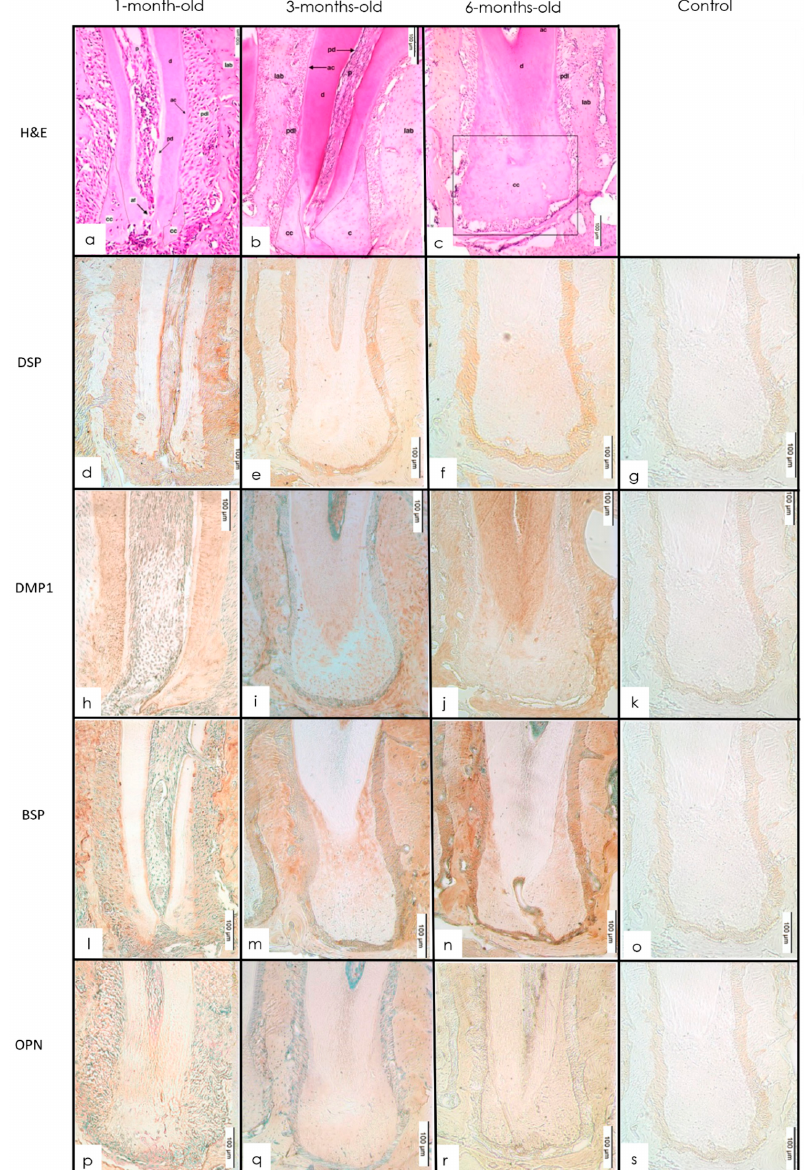
Figure 5. ( a – c ) H&E molar showing cementum at 1-, 3-, and 6-month-old mice (H&E 20 × ). The cementum and apical bone are well-developed in all age groups and the root apex continues develop- ing with abundant cellular cementum. d—dentin; pd—predentin; o—odontoblastic layer; p—pulp; fb—furcal bone; pdl—periodontal ligament; tf—transeptal fibers; Iab—interproximal alveolar bone; cc—cellular cementum; ac—acellular cementum; af—apical foramen. ( d – g ) Expression of staining intensity of DSP at 1, 3, and 6 months in cellular cementum and PDL of the tooth root. With anti- DSP (IHC 20 × ). Intensity decreased from 1 to 3 months followed by a slight increase at 6 months. ( h – k ) IHC staining of cellular cementum and PDL in tooth root in 1-, 3-, and 6-month-old mice with anti-DMP1 (IHC 20 × ). The intensity increased from 1 to 3 months followed by an increase between 3 and 6 months. ( l – o ) IHC staining of cellular cementum and PDL in tooth root in 1-, 3-, and 6-month-old mice with anti-BSP (IHC 20 × ). The intensity increased slightly from 1 to 3 months followed by an increase between 3 and 6 months. ( p – s ) IHC staining of cellular cementum and PDL in tooth root in 1-, 3-, and 6-month-old mice with anti-OPN (IHC 20 × ). Insignificant changes in intensity were seen between 1 and 3, and 3 and 6 months,